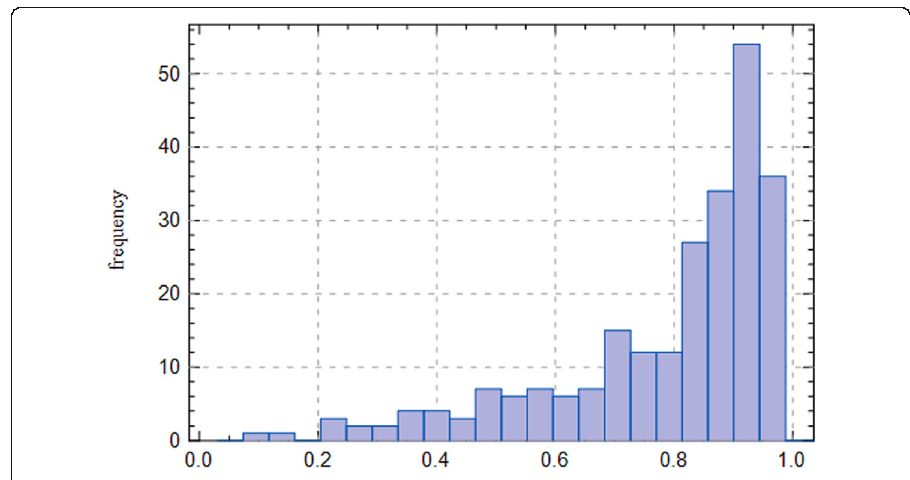
Fig. 2 Histogram of technical efficiency scores